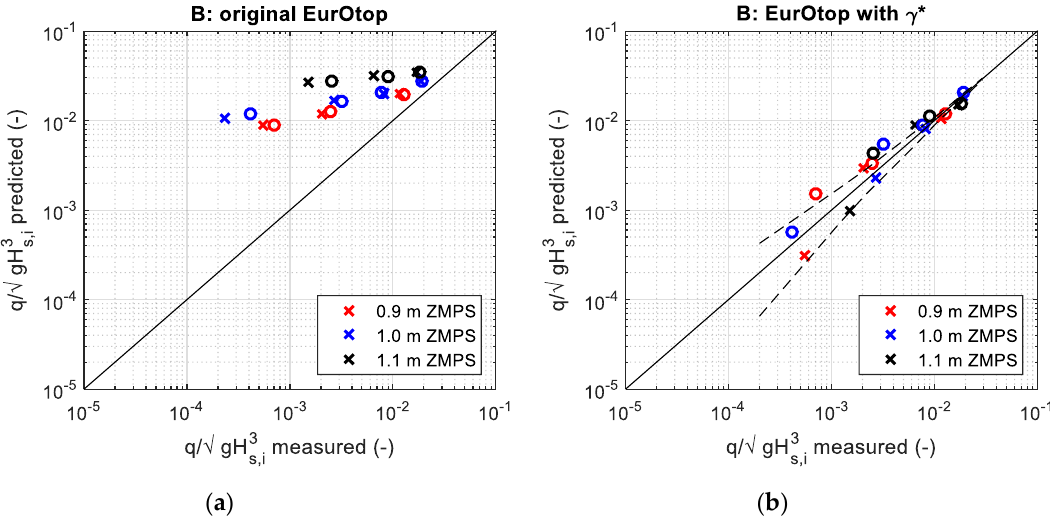
Figure 12. Measured overtopping and predictions for the cross-sections B: according to EurOtop ( a ), applying γ* ( b ) . Crosses (x) are relative to S op = 0.063, circles (o) are relative to S op = 0.048. Dashed lines are the upper and lower 95% prediction bounds.